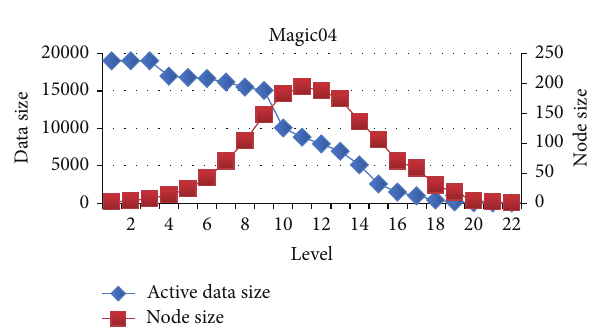
Figure 20: Speedup of level of MiniBooNE.